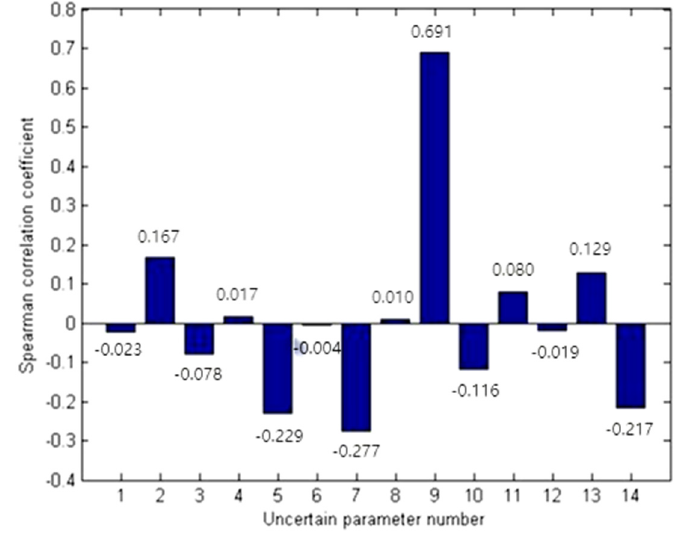
Figure 11. Spearman rank correlation coefficient of input parameters for hydrogen production in 38 mm LOCA.